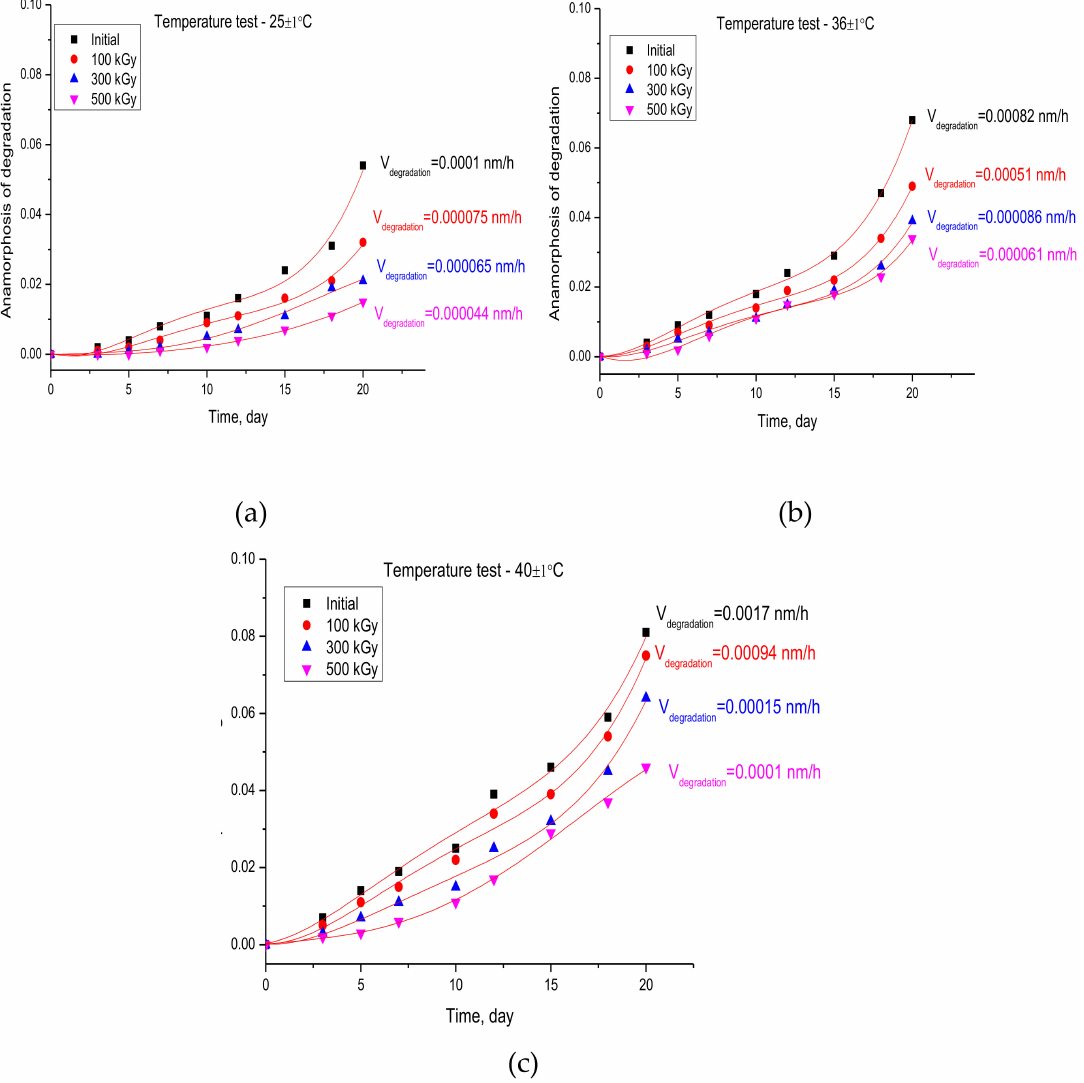
Figure 4. Dynamics of changes in the rate of degradation of nanostructures in a PBS solution (dots indicate experimental data, red lines indicate approximations of the results obtained, necessary to determine the rate of degradation reaction): ( a ) at a test temperature of 25 ◦ C; ( b ) at a test temperature of 36 ◦ C; ( c ) at a test temperature of 40 ◦